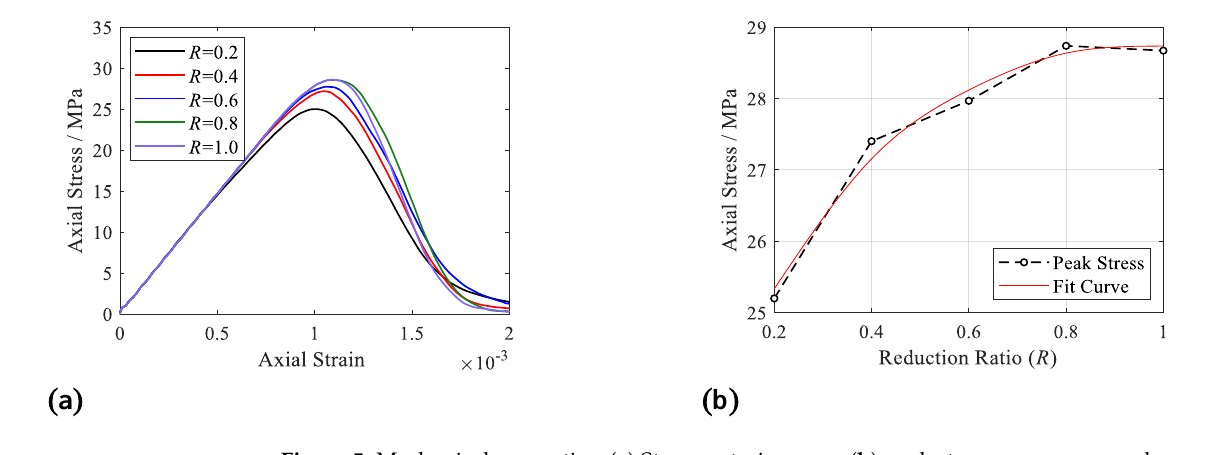
Figure 5. Mechanical properties. ( a ) Stress—strain curve; ( b ) peak stress summary graph.